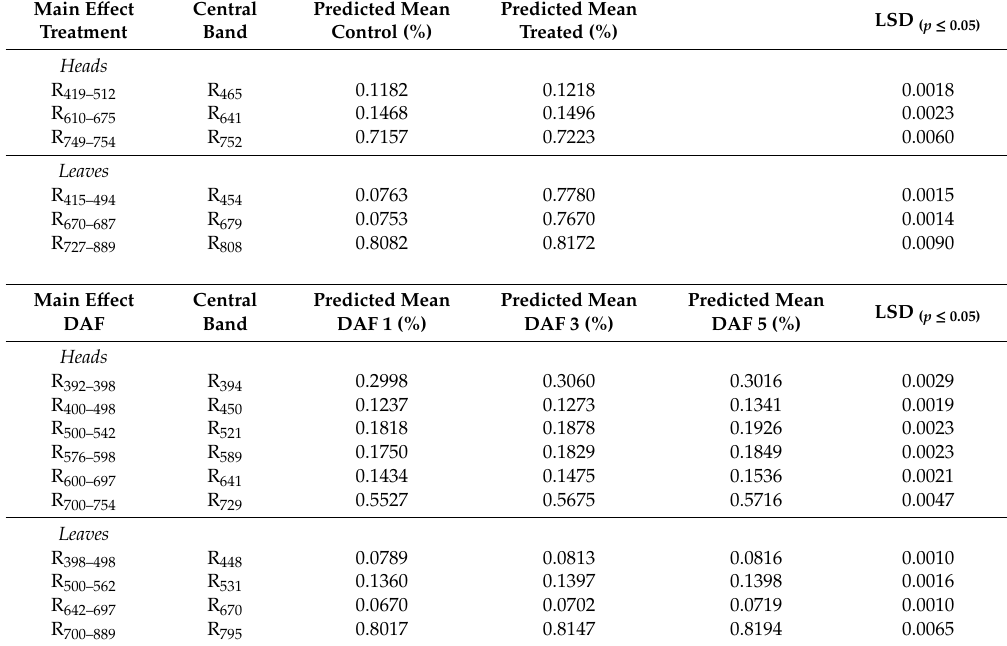
Table 1. Regions of the electromagnetic spectrum (EMS) with a significant main e ff ect of the frost treatment and DAF, with no interaction, and predicted mean reflectance of the central bands in each of these